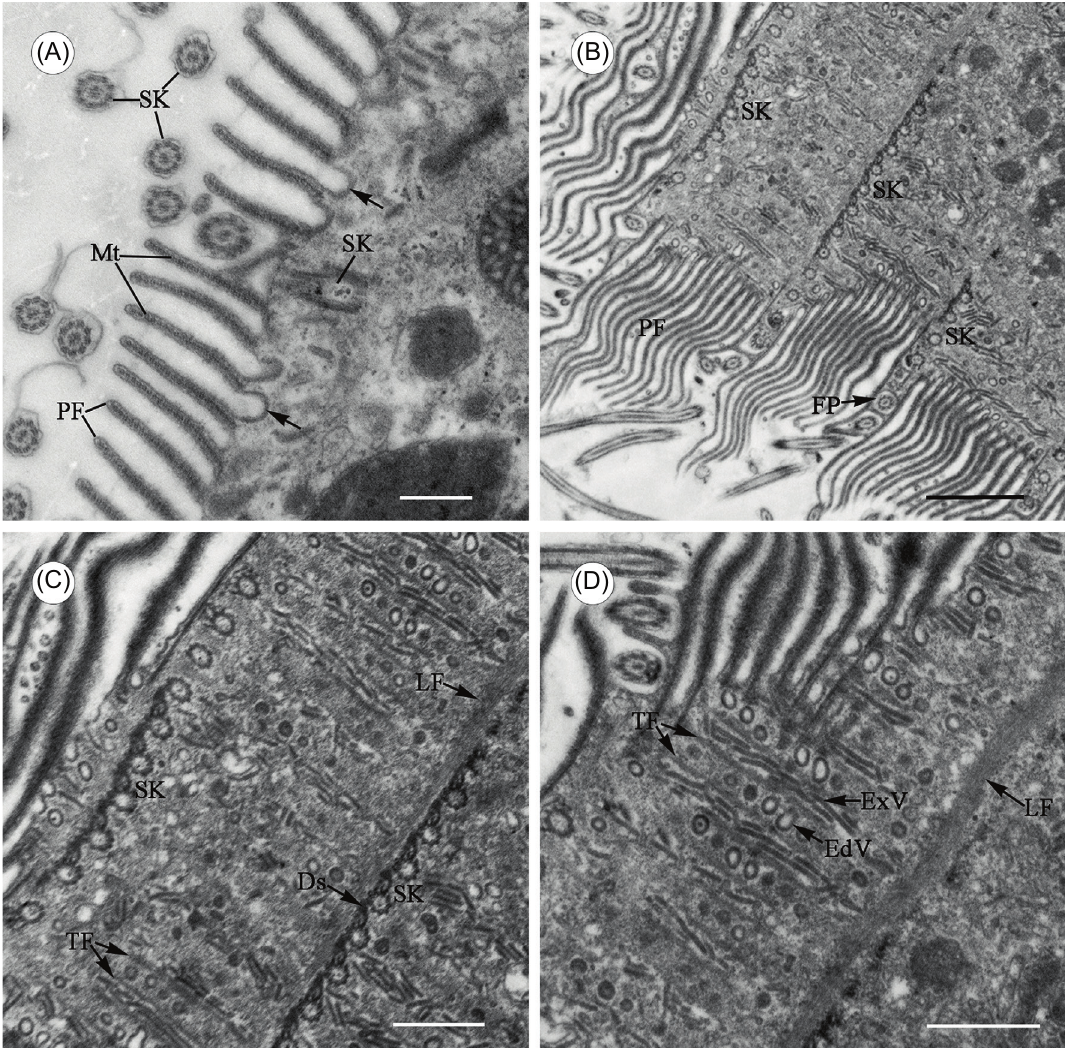
Figure 2. Transmission electron microscope images of Cepedea longa , to show fine structures of the somatic cortex. (A) Section tangent to cell surface, to show pellicular folds (PF) supported by ribbons of microtubules (Mt). Some coated vesicles are fused with the plasma membrane and seen as invaginations (arrow). SK = somatic kinetosomes. Scale bar = 5 l m. (B) Section passing parallel to cell surface, to show pellicular folds (PF) interposing between somatic kineties (SK). FP = flagellar pit. Scale bar = 20 l m. (C)–(D) Selected enlargement of Figure 2A, to show a developed fibrillar skeletal system in the somatic cortex. Longitudinal microfibrils (LF) border the somatic kineties (SK) joined to each other by desmoses (Ds) on the left side, with transversal fibrils (TF) running perpendicular to kinetal long axes and framing the ribs of the cortical vesicles: globular endocytotic vesicles (EdV) and elongated exocytotic vesicles (ExV). Scale bar = 10 l